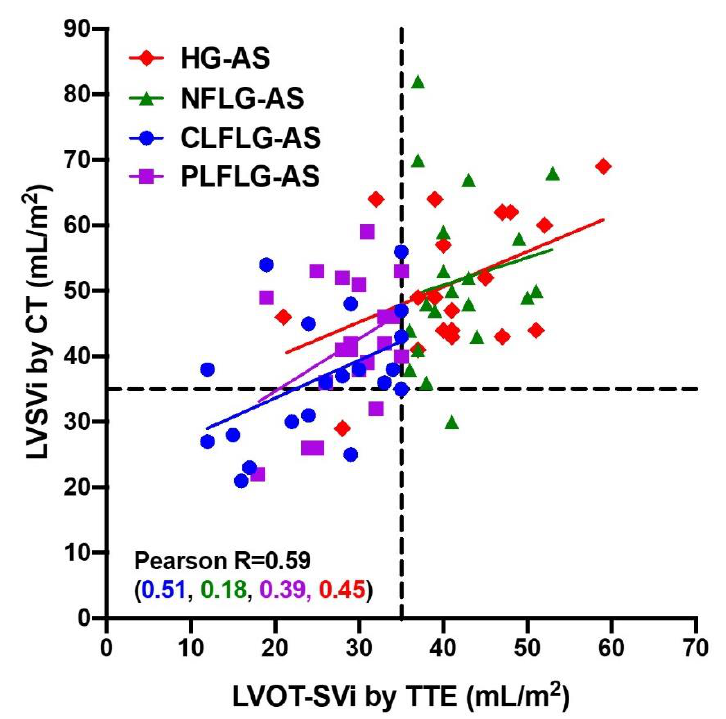
Figure 4. Correlations between transthoracic echocardiography (TTE) and 4-dimensional cardiac computed tomography (4D-CCT) of left ventricular stroke volume indexed for aortic stenosis clas- sification. Scatterplot of left ventricular outflow tract stroke volume indexed (LVOT-SVi) by TTE against left ventricular stroke volume indexed (LVSVi) by 4D-CCT. Pearson correlation coefficient indicated for the whole cohort and subgroups of aortic stenosis (AS) cohort by TTE definitions: high gradient (HG-AS), classical and paradoxical low-flow low-gradient (CLFLG-AS and PLFLG-AS), and normal-flow low-gradient (NFLG-AS).